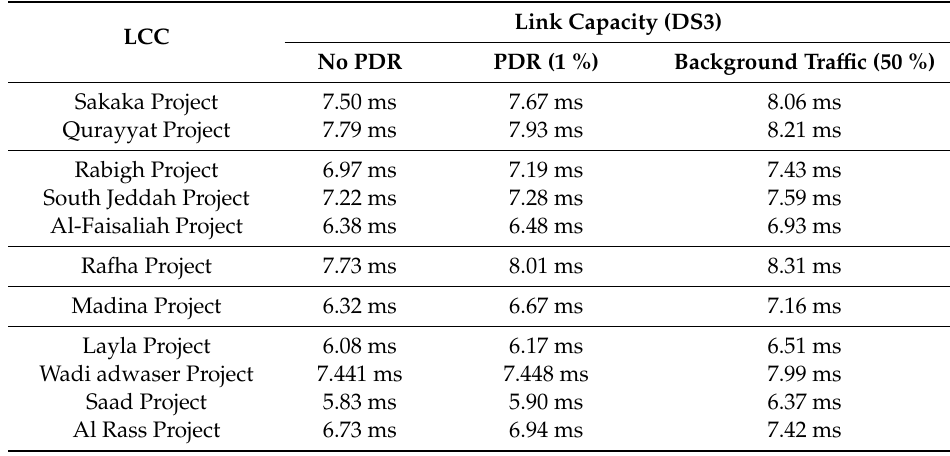
Table 12. End-to-end delay between PV power plant and the central control center. PDR: packet discard